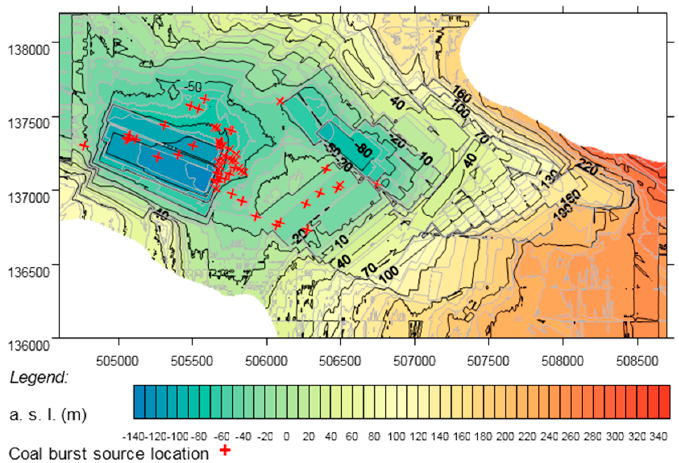
Figure 6. Excavation work and coal burst source locations at the VCM.